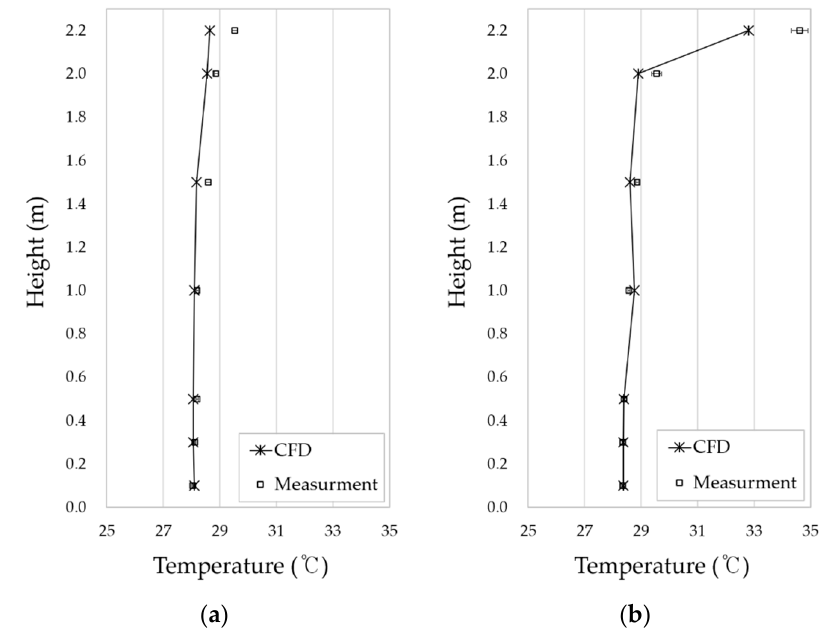
Figure 6. Temperature distribution of CFD and measuring data: ( a ) temperature distribution in the living room; ( b ) temperature distribution in the kitchen.